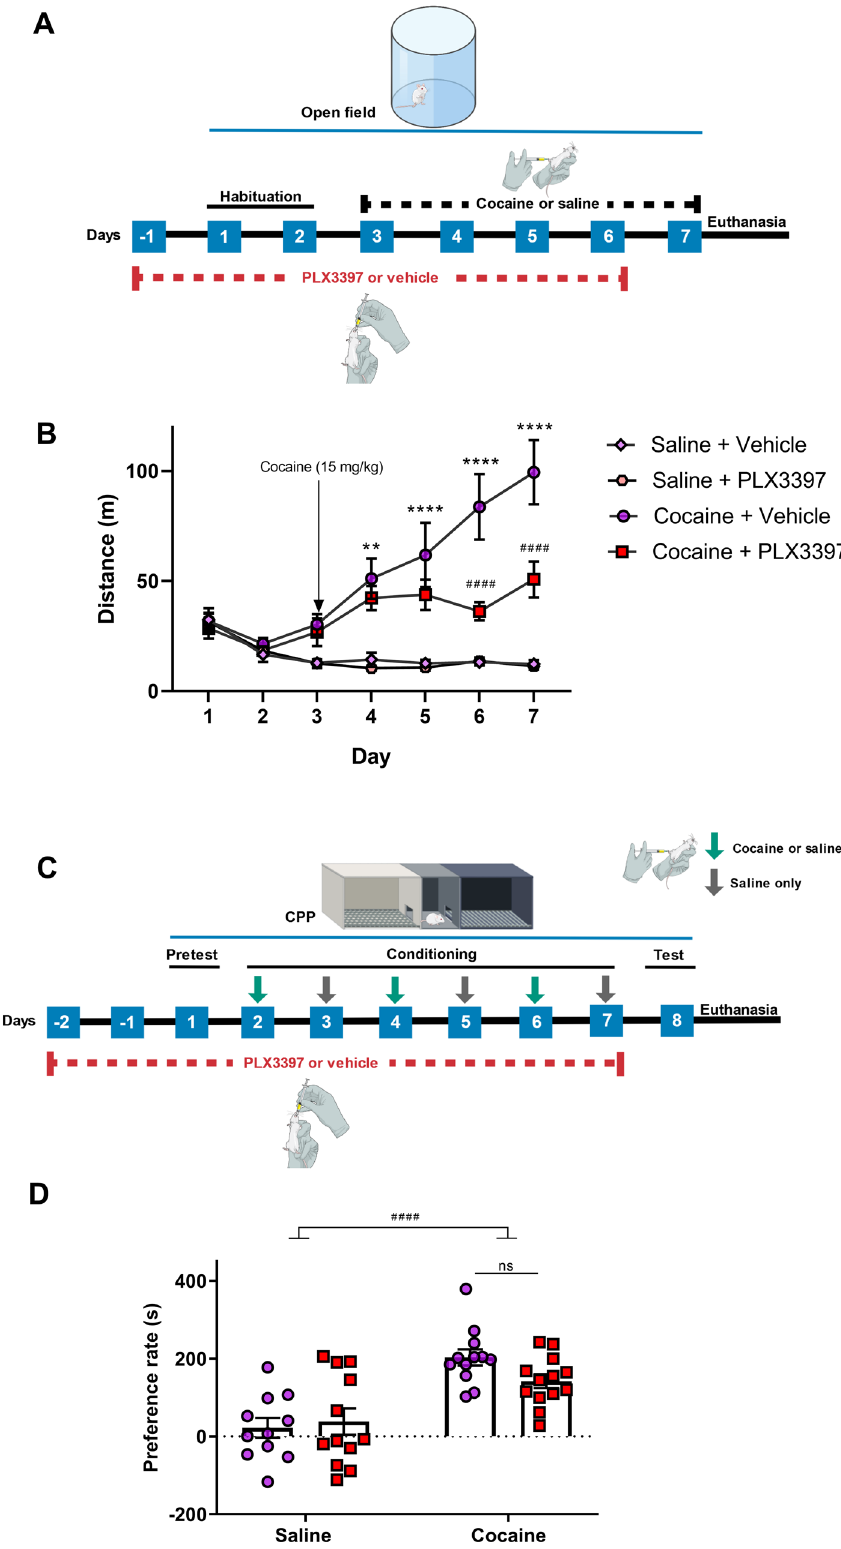
Figure 1. Effect of partial microglia depletion on the behavioral sensitization and conditioned place preference induced by cocaine. Experimental design of behavioral sensitization ( A ). Daily distance travelled by animals injected with cocaine or saline in the behavioral sensitization test [treatment factor (F (3,24) = 18.85; p < 0.0001), time factor (F (4,96) = 15.59; p < 0.001), interaction (F (12,96) = 9.72; p < 0.0001)] (n = 6–8 in each group) ( B ). Experimental design of conditioned place preference ( C ). Rate of preference in the conditioned place preference test [cocaine factor (F (1,45) = 34.32; p < 0.0001), CSF1R inhibition factor (F (1,45) = 0.29; p = 0.5916) and cocaine vs CSF1R inhibition factor (F (1,45) = 3.36; p = 0.0734)] (n = 11–13 in each group) ( D ). Results are expressed as mean ± SEM. # p < 0.05 difference between the saline and cocaine groups; ***p < 0.001 and ****p < 0.0001 compared with the PLX3397 treated